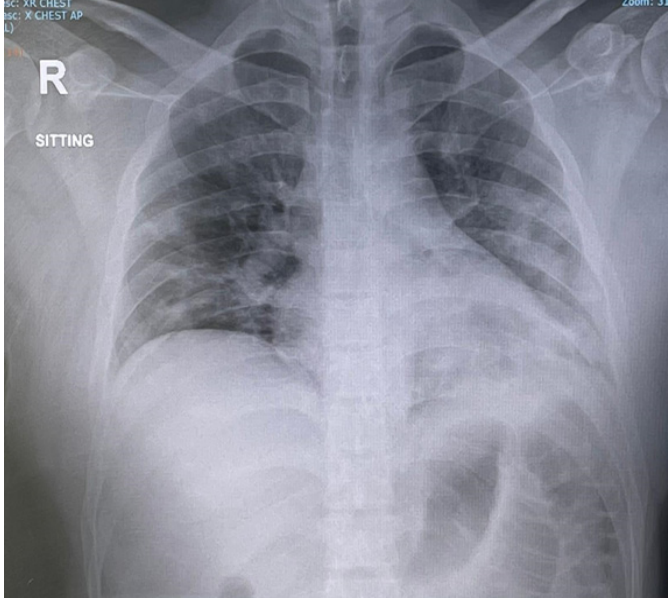
Figure 1. Chest X-ray showing bilateral lung infiltrates.